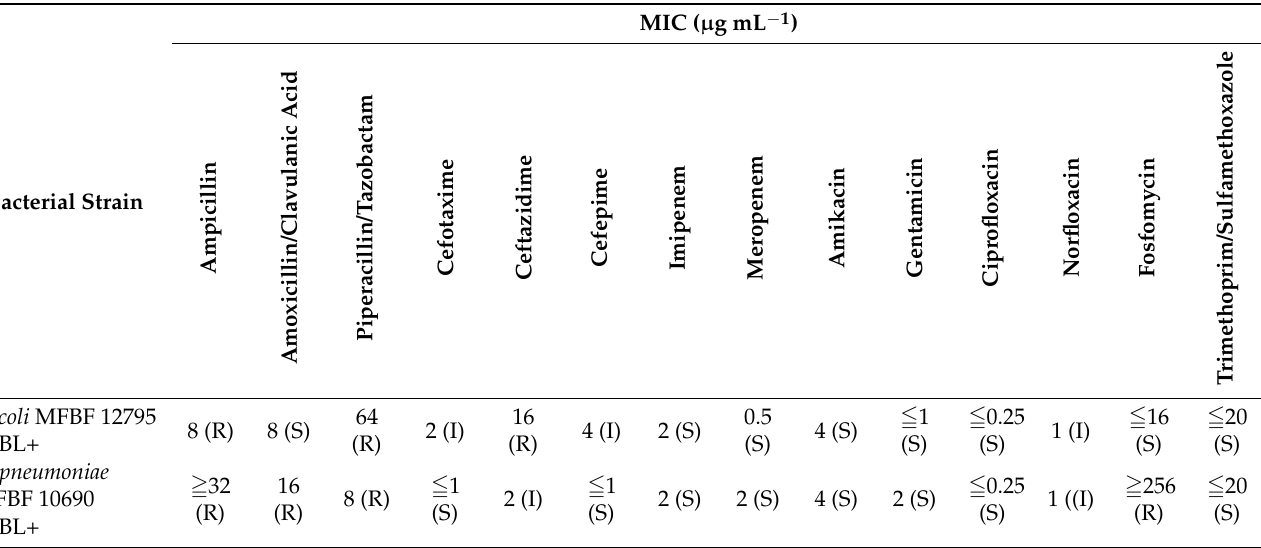
Table 1. Susceptibility testing of ESBL-positive clinical strains used in the